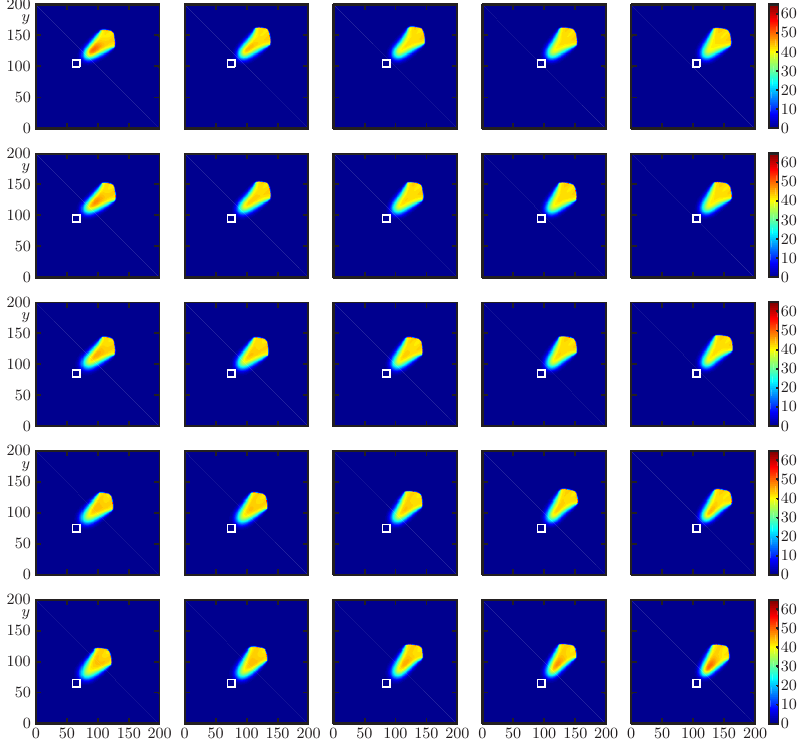
5 = 25 initial fire foci, marked by × . T 1